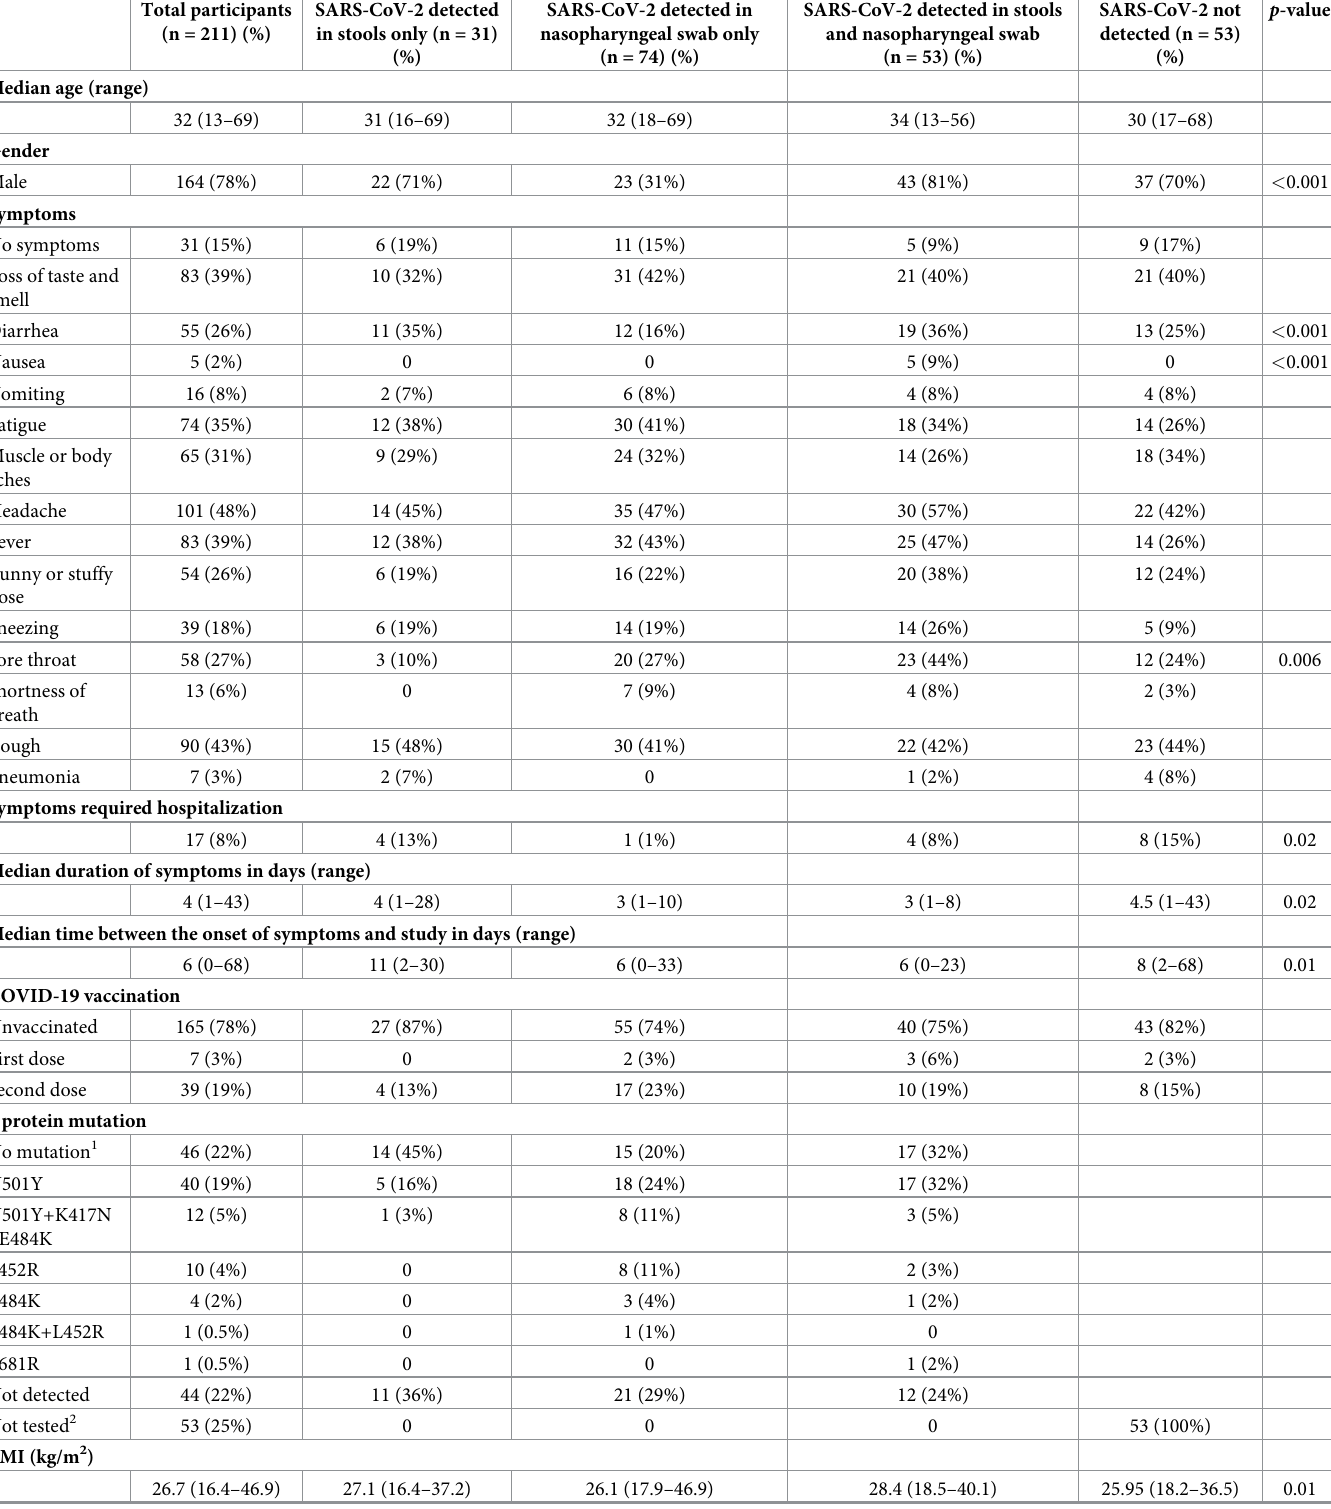
Table 1. Baseline characteristics of the participants categorized by sample